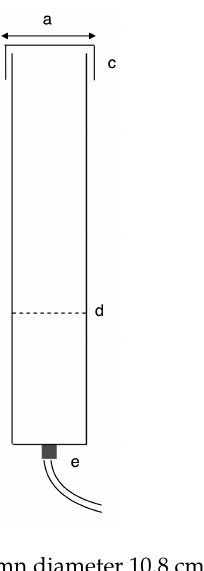
Figure 3. Bubble column apparatus. ( a ) Column diameter 10.8 cm; ( b ) column height 120 cm, ( c ) lid, ( d ) culture level (4 L = 47 cm gas-free liquid height, 3.2 L = 36 cm gas-free liquid height), ( e ) CO 2 control valve.